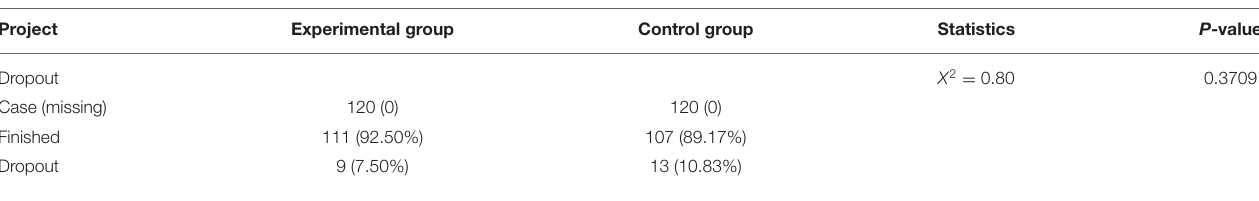
TABLE 3 | Comparison of dropout rates between the two